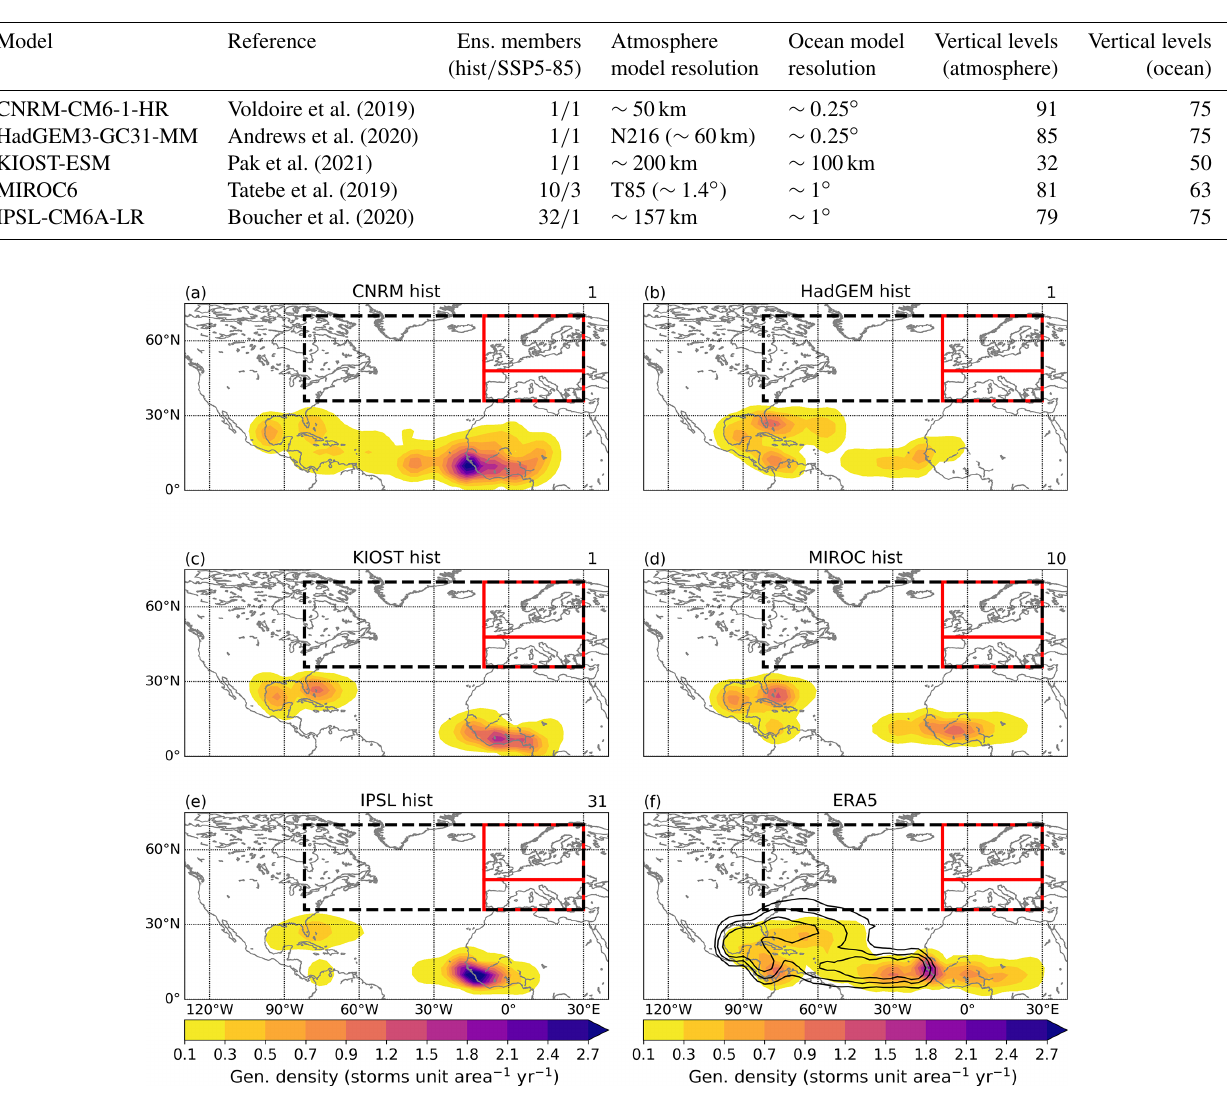
Table 1. Summary of the CMIP6 models used in this study, including model name (column 1), reference to model development (column 2), number of ensemble members used (column 3), atmospheric model resolution (column 4), ocean model resolution (column 5), and number of vertical layers in the atmosphere (column 6) and ocean (column 7) models.